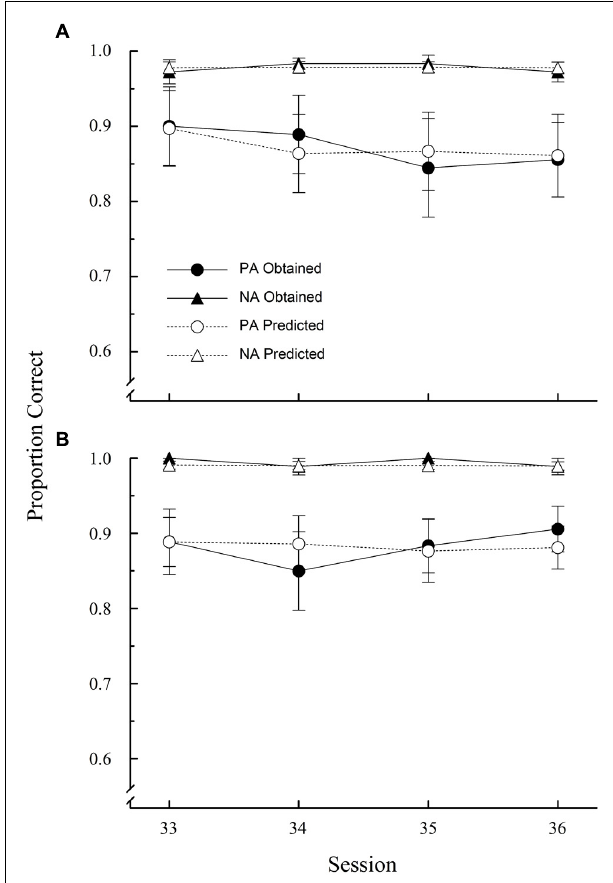
FIGURE 5 | Starlings’ asymptotic accuracy over the last four sessions (black symbols) and simulated accuracy (white symbols) according to Wynne’s configural model ( ± 1 SEM); (A) Group Continuous; (B) Group